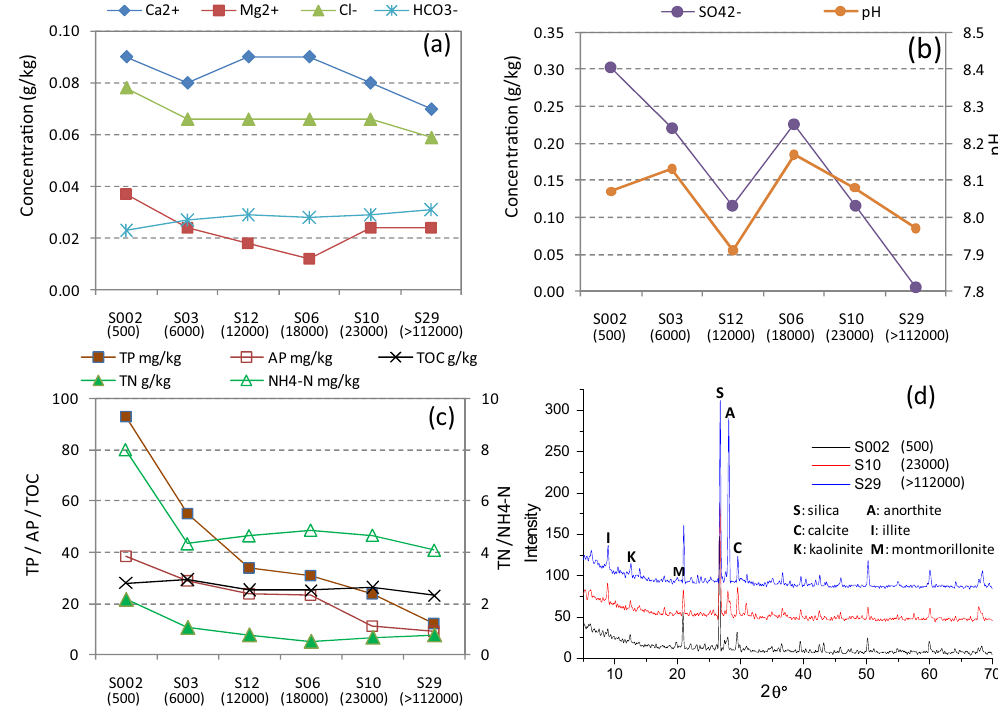
Figure 1. Soil physical and chemical properties (the numbers in bracket are CO 2 concentrations; unit: